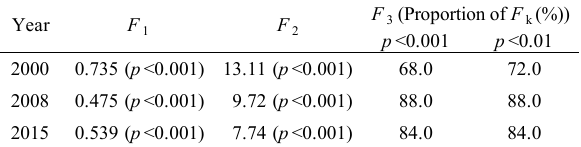
Table 2. Results of the validation of GWR